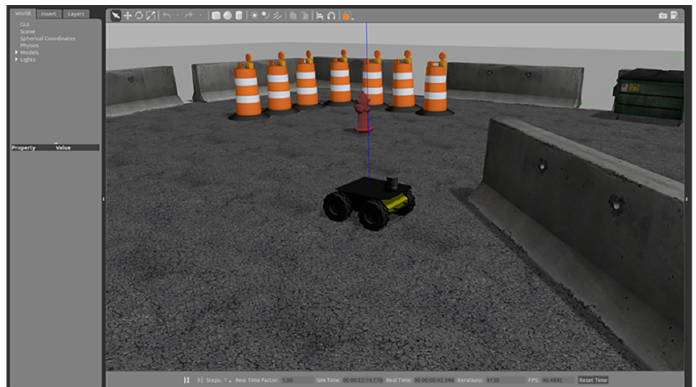
Figure 11. Example of a Gazebo simulation environment.